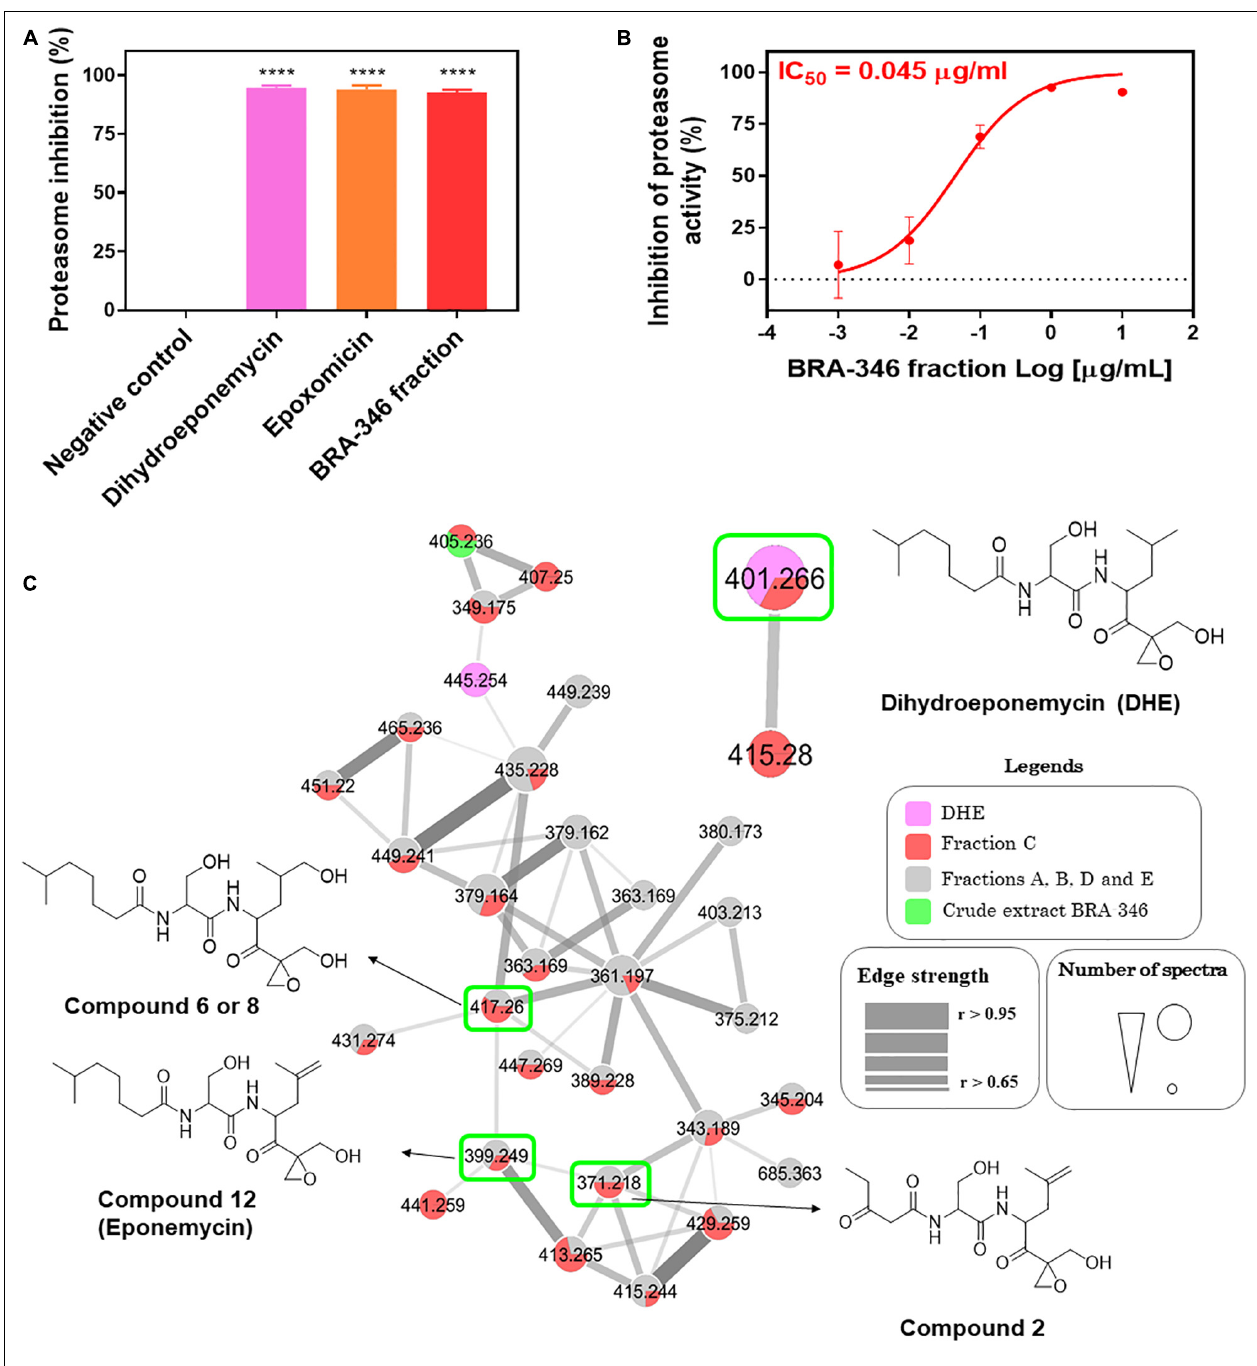
FIGURE 2 | Evaluation of proteasome inhibition by dihydroeponemycin, epoxomicin, and BRA-346 epoxyketone-containing fraction, and molecular networking profile of proteasome inhibitors, BRA-346 crude extract, and fractions. (A) Comparative graph of inhibition of the catalytic activity of the Chymotrypsin-like (ChTL) subunit of the proteasome by dihydroeponemycin and epoxomicin (at 12 and 16.6 µ g/mL, respectively), and BRA-346 fraction (fraction C Supplementary Figure 1 ) (at 1 µ g/mL) through the enzymatic assay. Data were analyzed using GraphPad Prism 7.0 software by ANOVA followed by Tukey multiple comparison test, **** p -value < 0.0001. (B) Dose-response curve of the proteasome inhibition test by BRA-346 fraction, with IC 50 value = 0.04 µ g/mL, confidence interval (CI 95%) = 0.02 to 0.07. All values were obtained from three independent experiments. (C) Molecular network profile of dihydroeponemycin, BRA-346 crude extract and fractions A, B, C, D, and E. Compounds were analyzed by grouping from the fragmentation profile data of the compounds obtained by the ESI positive mode (ESI+). Only clusters related to dihydroeponemycin are shown. Nodes represent the ions present in the samples, which are indicated by related colors. Highlighted nodes refer to dihydroeponemycin ( m/z 401.2) and analog ions present in the BRA-346 fractions.